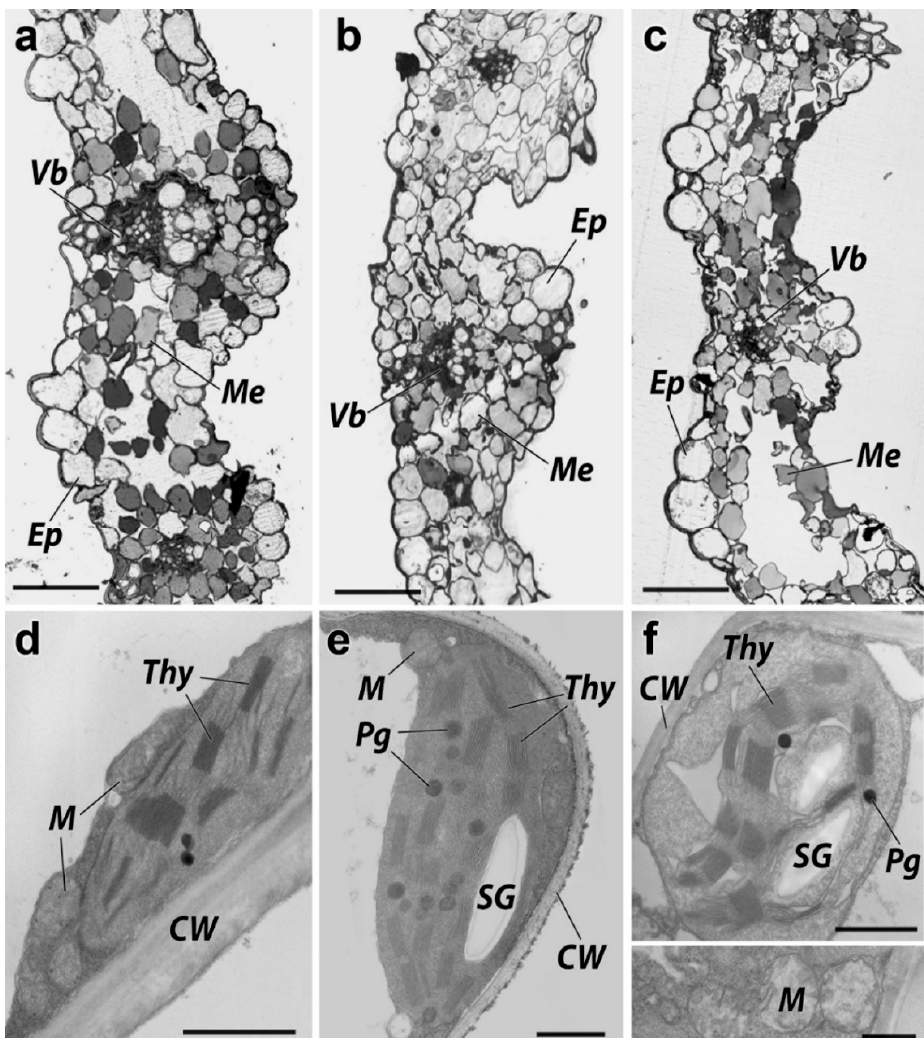
Figure 8. Cross-section of a barley leaf plate: ( a , d ) control, ( b , e ) hydroponically grown H. sativum with 300 mg/L ZnO NPs, ( c , d ) hydroponically grown barley with 2000 mg/L ZnO NPs.